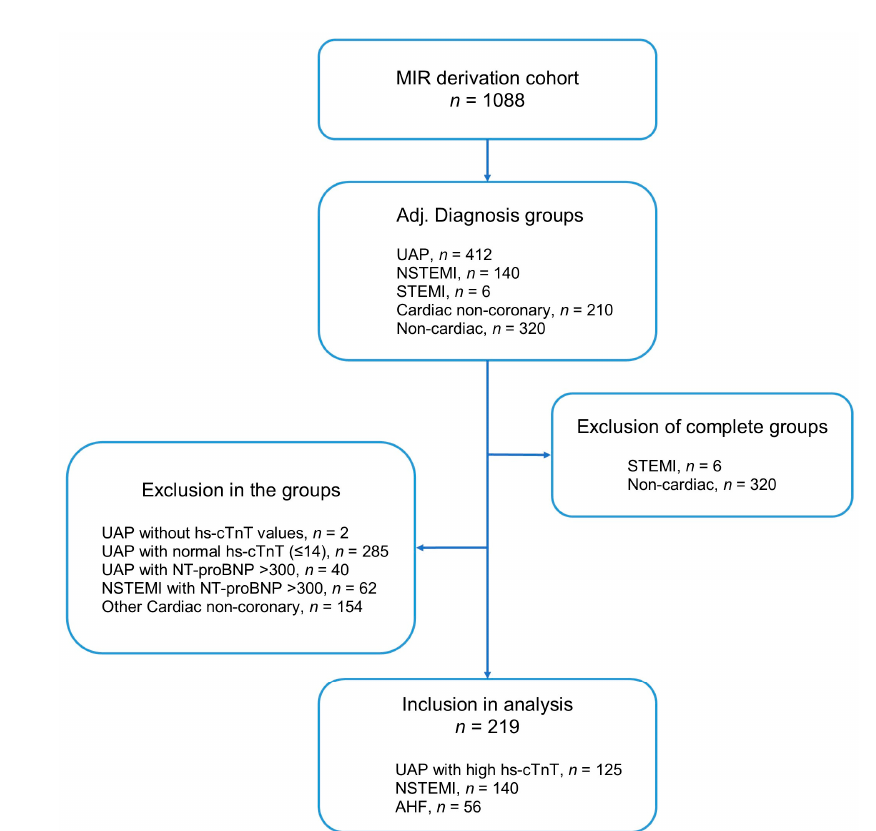
Figure 1. Consort diagram derivation cohort. Abbreviations: AHF: acute heart failure; hs-cTnT: high sensitivity cardiac troponin T; NSTEMI: non-ST-segment elevation myocardial infarction; NT-proBNP: N-terminal pro-B-type natriuretic peptide; STEMI: ST-segment elevation myocardial infarction; UAP: unstable angina